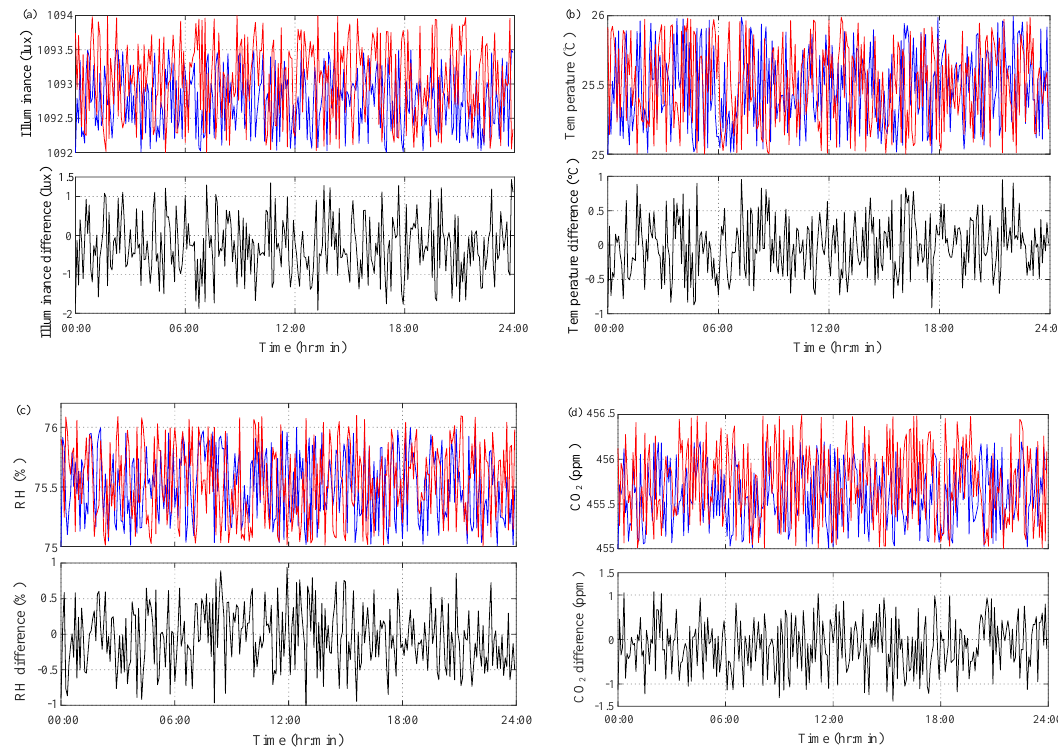
Figure 6. 24-h measurement results of pre-calibration process. ( a ) Illuminance; ( b ) temperature; ( c ) relative humidity (RH); ( d ) CO 2 (blue line—sensor; red line—instrument; black line—difference).